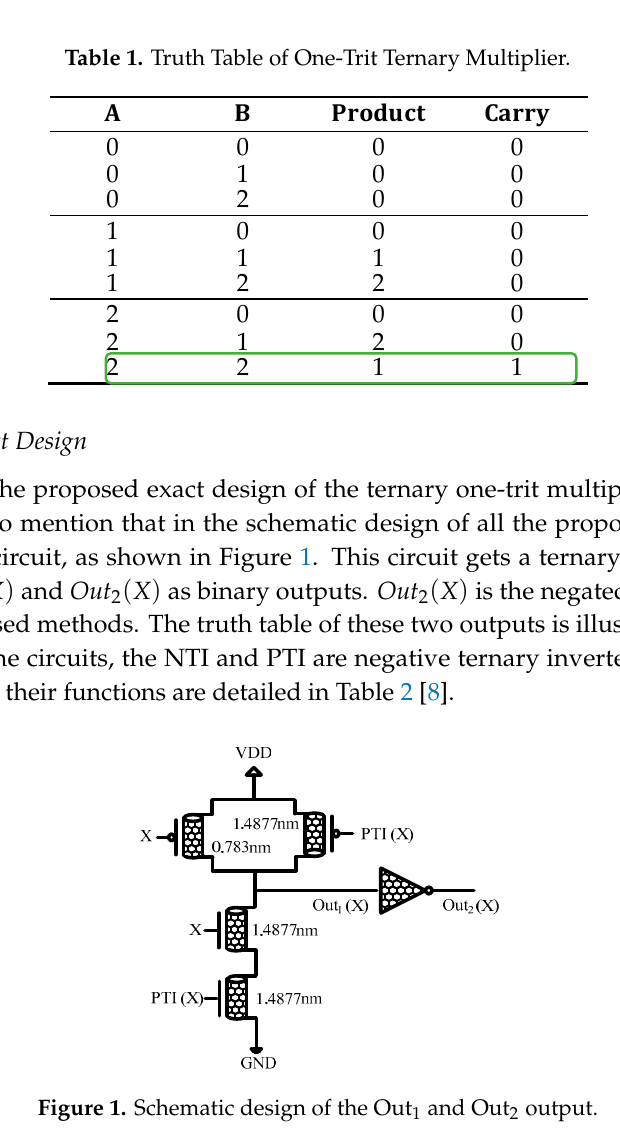
Figure 1. Schematic design of the Out 1 and Out 2 output. Table 2. Truth Table of Ternary NTI, PTI, Out1, and